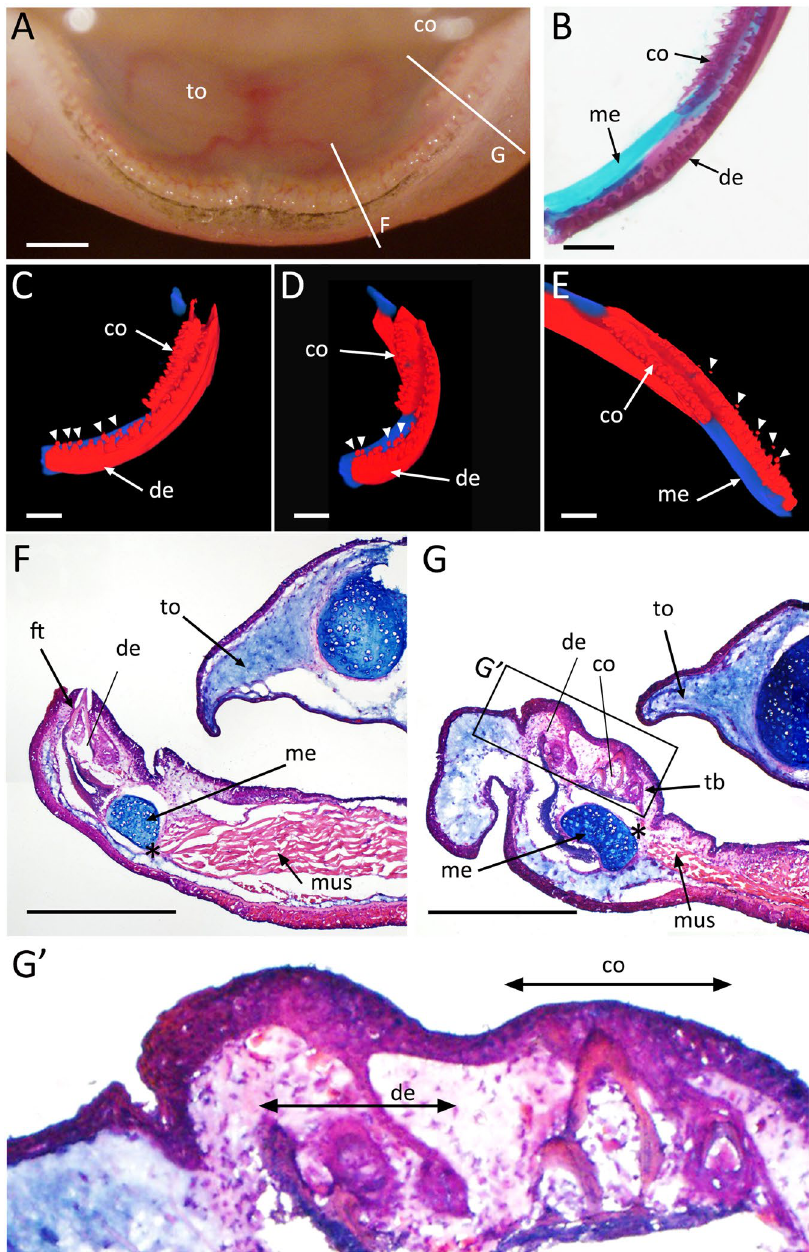
Figure 1. Axolotl mandibular structure. ( A ) Axolotl mandible. ( B ) Histological observation of the axolotl mandible. Alizarin red and Alcian blue staining show bones in red and cartilages in blue. The medial line is on the left and the lateral side is on the right. ( C–E ) CoMBI imaging. Bones and cartilage are shown in red and blue, respectively. The left mandible shown in B was sectioned and reconstructed into 3D images. Arrowheads indicate rootless teeth. Data are representative of n = 5 of axolotl mandibles. ( F, G ) Histological observation of the axolotl lower jaw. The approximate section lines are indicated in Fig. 1A. G’ is the higher magnification view of the boxed region in G. Asterisks indicate the connecting region between the Meckel’s cartilage and muscles. Hematoxylin/Eosin/Alcian blue staining was performed on the sections indicated in A. co = coronoid. de = dentary. ft = functional tooth. mus = Muscles. me = Meckel’s cartilage. tb = tooth bud. to = tongue. Scale bars = 1 mm. Data are representative of n = 8 of axolotl